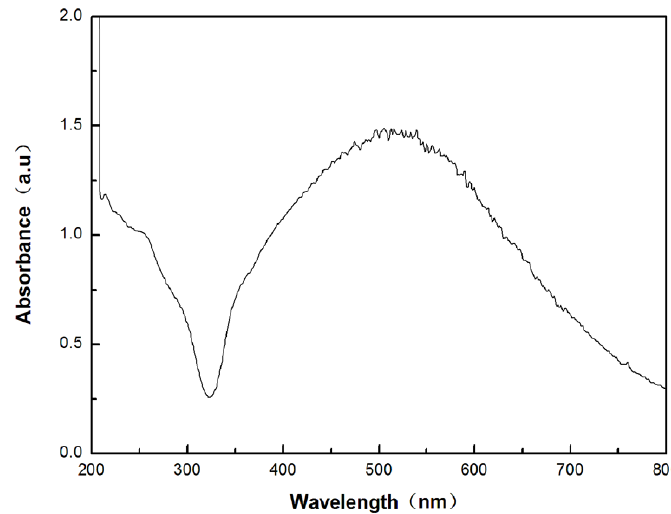
Figure 5. UV-visible absorption spectra of Ag/AgCl nanoparticles.